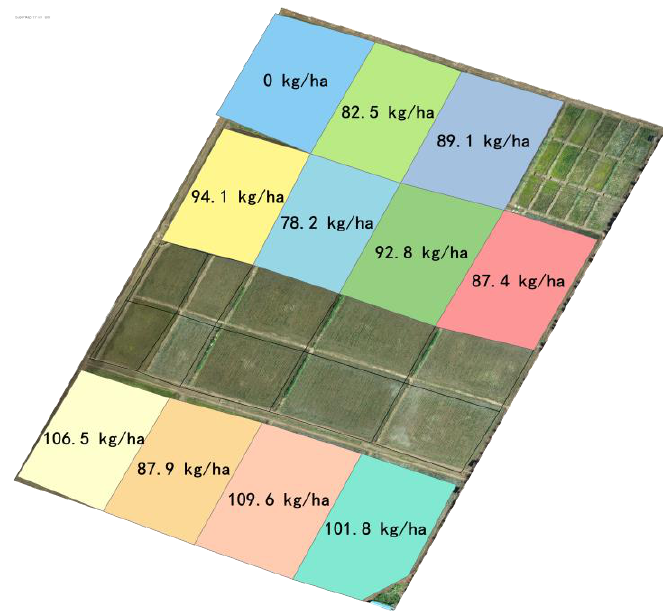
8 of 12 Figure 5. Inverse modeling of nitrogen content of rice. 3.4. Rice Fertilization Prescription Map Generation for Agricultural UAVs A UAV fertilizer-chasing operation needs to consider parameters such as the flight speed and spray width of agricultural drones, as well as the response time of the spread- ing system. Since the UAV hyperspectral remote sensing image is continuous information in a two-dimensional space, each pixel point can invert a fertilizer-chasing volume. In the actual operation, the agricultural UAV granular-fertilizer-spreading operation system